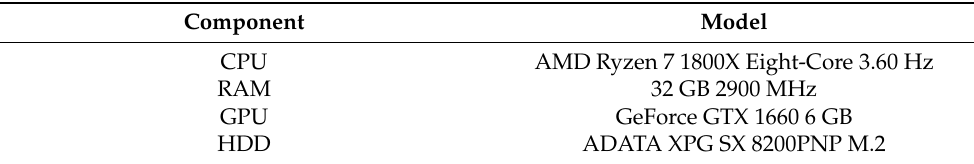
Table 3. Computer components configuration utilized in the computational